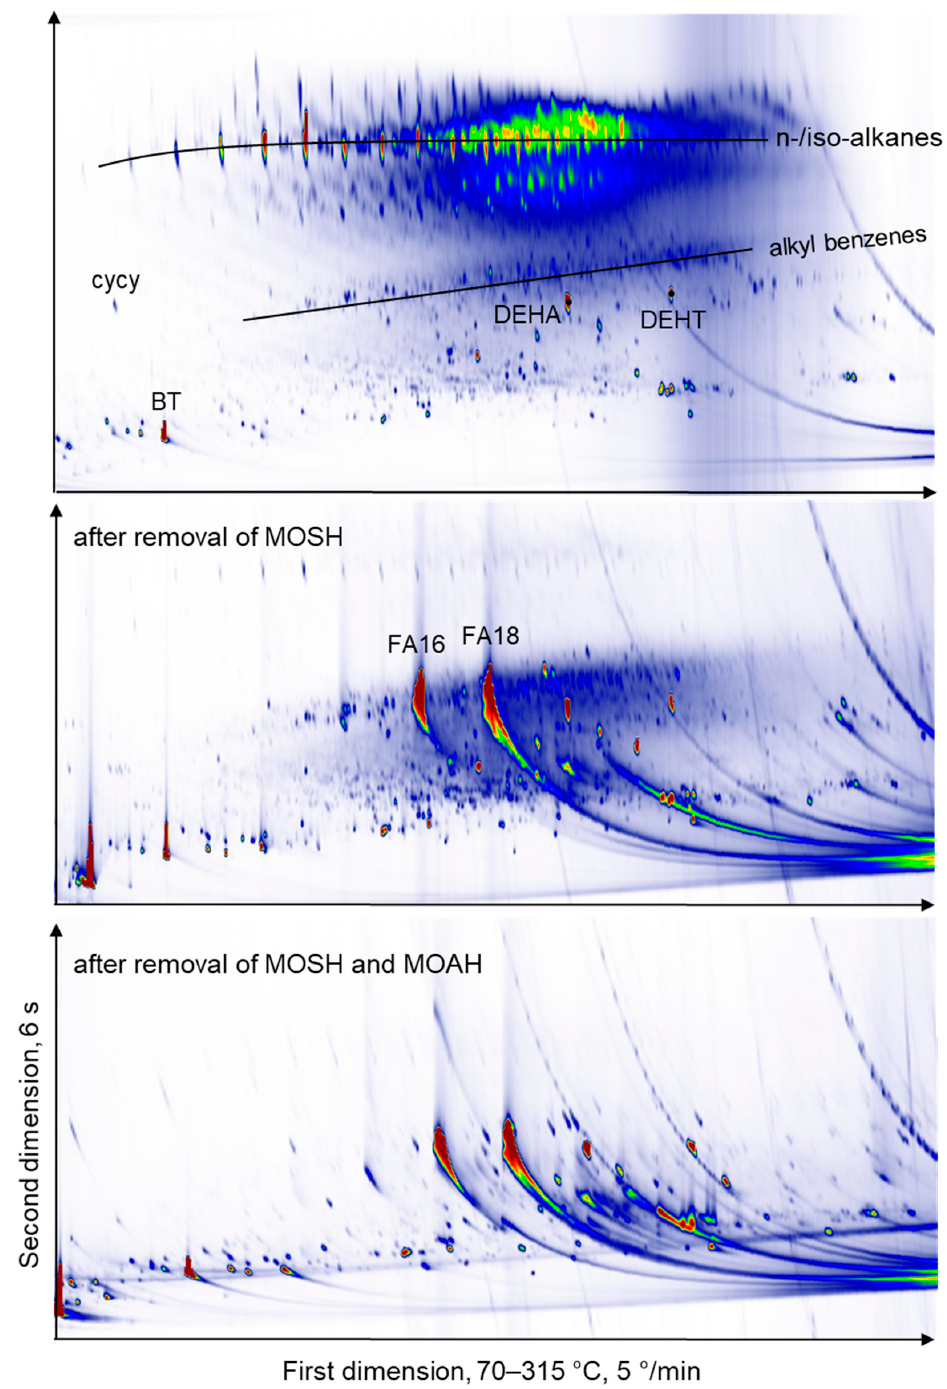
Figure 3. GC × GC-FID chromatogram of a styrene-butadiene-styrene/natural rubber (SBS/NR) sample (espresso maker gasket, #10). The top panel was run with PTV injection explaining the absence of free fatty acids. cycy: Cyclohexyl cyclohexane, BT: Benzothiazole, DEHA: Diethylhexyl adipate, DEHT: Diethylhexyl terephthalate, FA16: Palmitic acid, FA18: Stearic